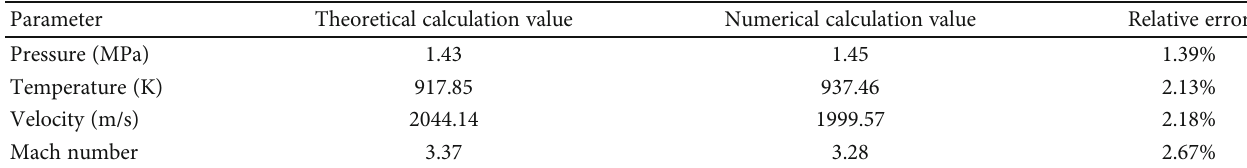
Table 3: Propellant